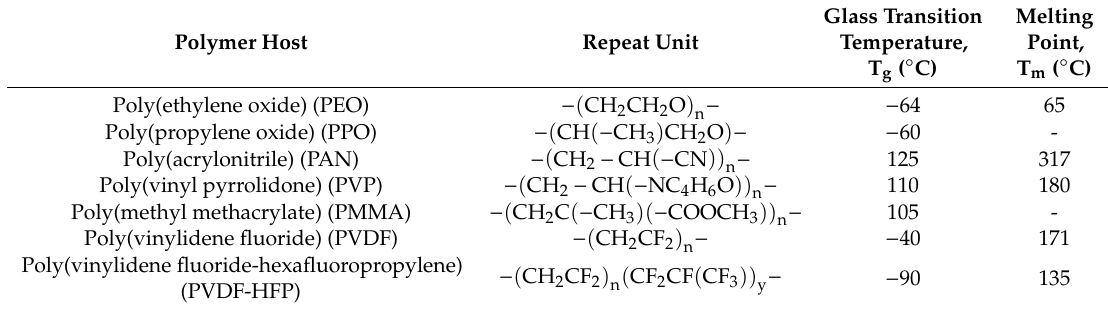
Table 6. Propertiesofthemostcommonsolventsandplasticizersusedtopreparegelelectrolytes[14,36,223]. Melting Organic Solvent